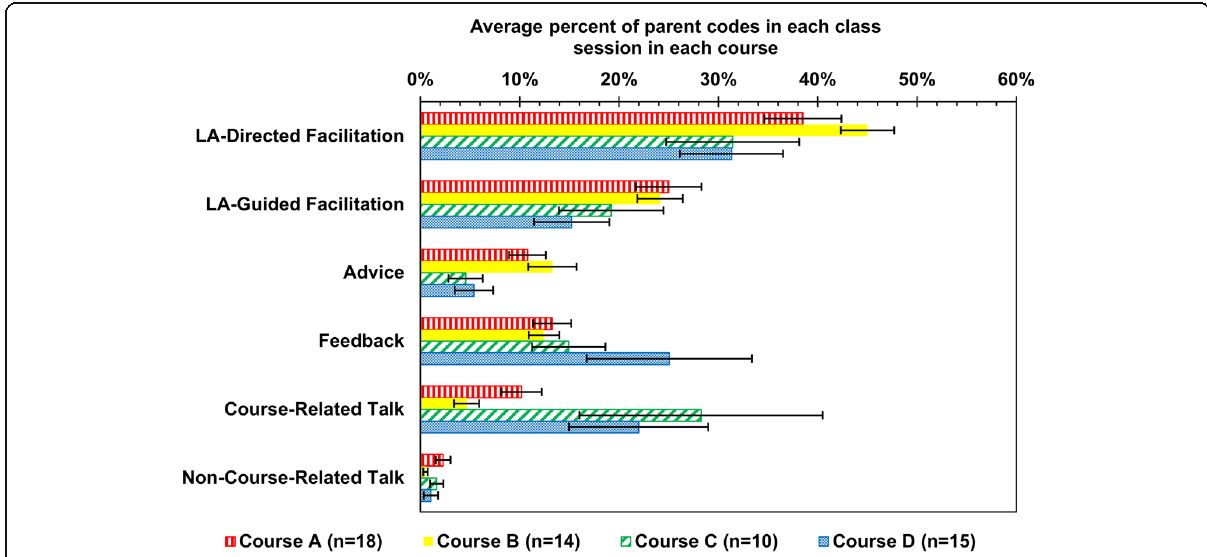
Fig. 4 Average percent of each parent code in each video session recorded in each of four courses. n signifies the number of video recordings of class sessions in each course. n varied from 10 to 18 for each course, with 2 to 3 LAs per course and 4 to 6 videos per LA. Error bars represent the